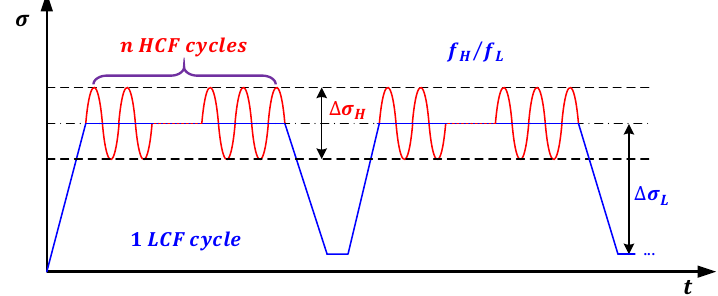
Figure 3. A load spectrum for CCF analysis.